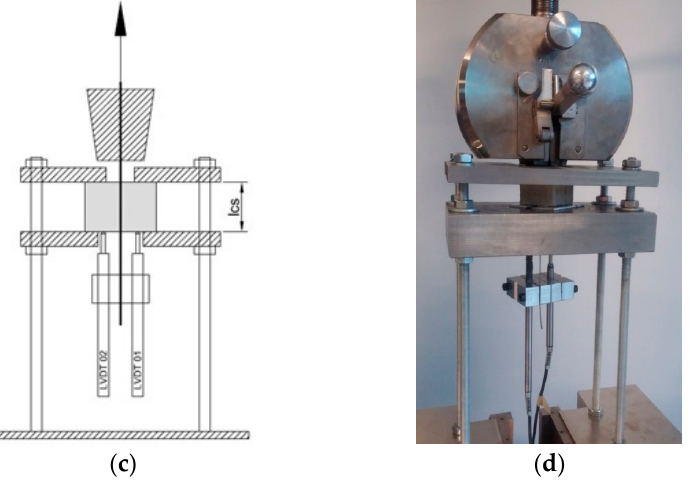
Figure 5. Test set-up for the cast ( a , b ) and printed ( c , d ) specimens.